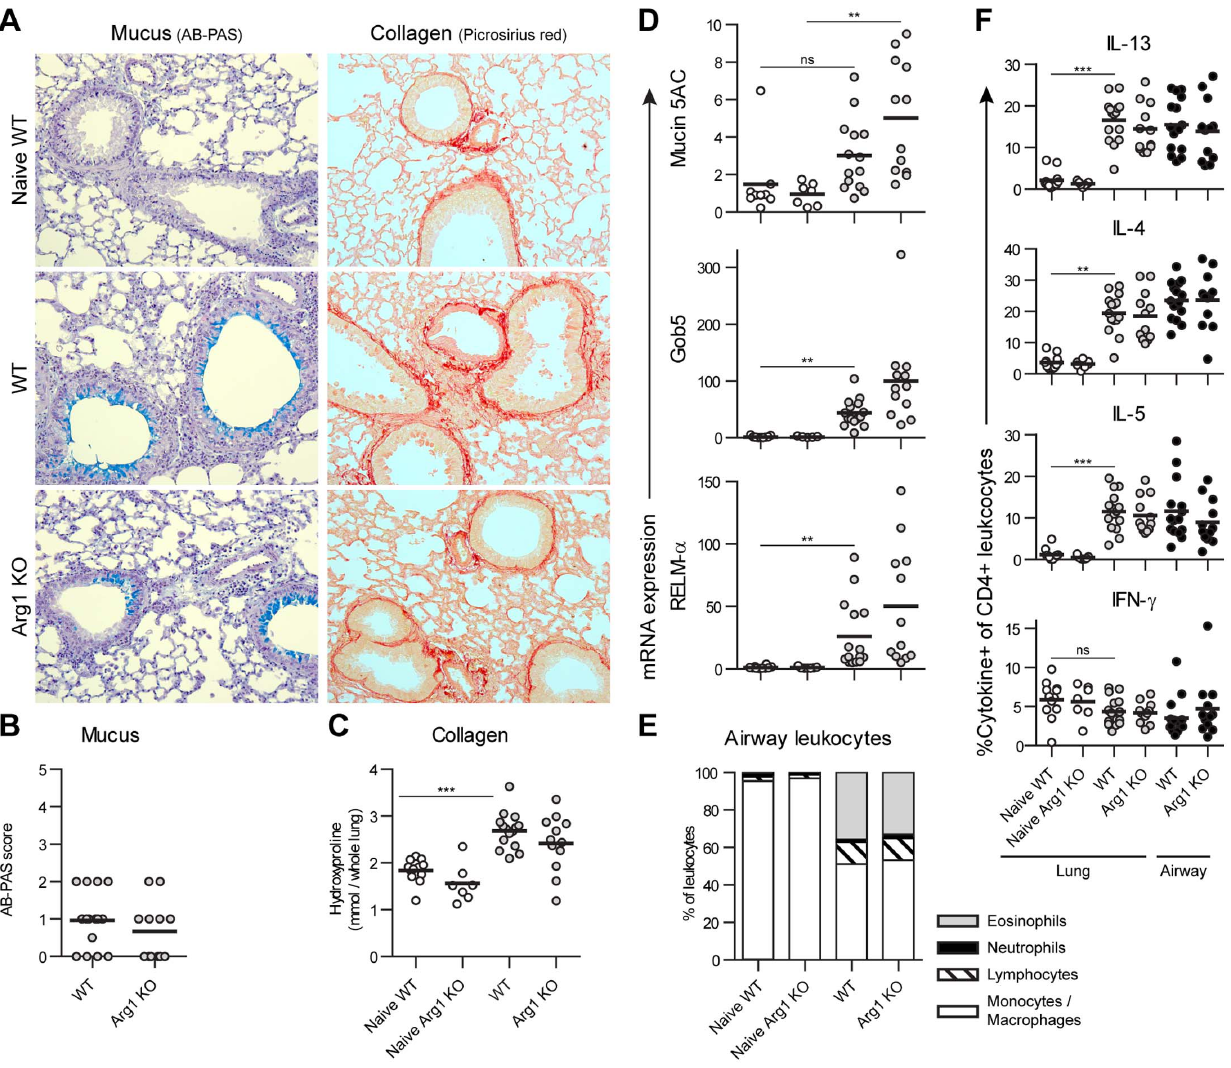
Figure 3. Arg1 expression by macrophages does not alter chronic SEA-induced airway inflammation. Arg1 KO mice were sensitized to schistosome eggs then treated with 8 weekly intra-tracheal challenges of soluble egg antigens to provoke chronic airway inflammation and analyzed 1 day after the final dose. A) The intensity and distribution of mucus (AB-PAS) and collagen (picrosirius red) were compared by histology in stained lung sections. Representative images of mucus-producing airway epithelium and underlying collagen deposition are shown. B) Mucus was visualized by AB-PAS staining and scored on a 0–5 point scale. C) Total lung collagen deposition was measured using L-hydroxyproline content. D) Induction of RELM- a , Mucin 5AC, and Gob5, and mRNA in lung tissue was compared by quantitative PCR, normalized to mean expression in naı¨ve mice. E) Leukocytes from the airways were recovered by broncho-alveolar lavage and categorized by cytospin analysis. Cell numbers did not differ between WT and Arg1 KO mice (data not shown). F) Lung and airway leukocytes were restimulated with PMA plus ionomycin, stained, and analyzed by flow cytometry to compare cytokine production by CD4 + T lymphocytes. No significant differences were observed between challenged WT and Arg1 KO mice. Results were combined from two independent experiments totaling 12 WT and 7 Arg1 KO naı¨ve mice, and 15 WT and 12 Arg1 KO challenged mice. Individual mice and group means are shown. doi:10.1371/journal.pone.0061961.g003 and data were analyzed using FlowJo (Tree Star) using for Foxp3 (FJK-16S, eBioscience), IL-10 (JES5-16E3, eBioscience), unstimulated and/or isotype controls of each sample to set gates. CD4 (GK1.5, Biolegend), CD45 (30F11, Biolegend), CD8 a (53- 6.7, Biolegend), and F4\80 (MF48-21, Invitrogen). Lung macro- phages were analyzed using Aqua live/dead, Foxp3 buffers, and Total or OVA-specific IgE Assay staining for CD45, F4\80 (BM8, Biolegend), CD11b (M1/70, Sera were obtained from blood collected by cardiac puncture of Biolegend), Gr-1 (RB6-8C5, Biolegend), Siglec-F (E50-2440, BD antigen- or vehicle-treated mice. Total or OVA-specific IgE serum Biosciences), Mannose Receptor (MR5D3, Biolegend), and levels were measured by ELISA using plates coated with anti- RELM- a (226033, R & D Systems) labeled with Alexa Fluor mouse IgE (Pharmingen R35-72) or OVA. Diluted serum samples 488 (Microscale Protein Labeling Kit, Life Technologies). Flow were added to each well, and bound IgE was detected with cytometry was performed using a FACSCanto II (BD Biosciences) biotinylated anti-mouse IgE (Pharmingen, R35-118), streptavidin conjugated horseradish peroxidase (Pharmingen), and HRP